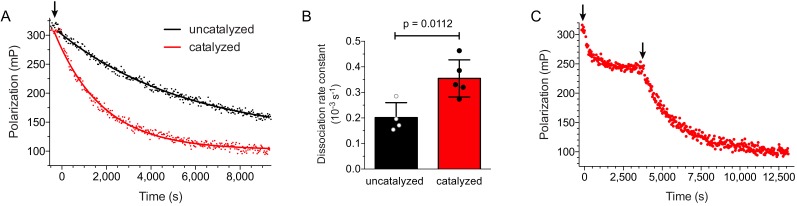
TAPBPRwt-catalyzed displacement of high-affinity peptide from H2-Db.(A) Peptide dissociation kinetics (representative traces) from H2-Db (300 nM) loaded with a fluorescently-labeled high-affinity peptide (ASNC*NMETM) was monitored in real time by fluorescence polarization. The arrow indicates the addition of a 1000-fold molar excess of unlabeled high-affinity peptide (ASNENMETM, 300 µM) without TAPBPRwt (black trace) or in combination with TAPBPRwt (1 µM, red trace). (B) Average rate constants of uncatalyzed (0.20 ± 0.06 × 10−3 s−1) and catalyzed dissociation (0.35 ± 0.07 × 10−3 s−1) of high-affinity peptide from H2-Db, using the same conditions as in (A). Data represent mean ± SD (uncatalyzed: n = 4; catalyzed: n = 5). The p value was determined using an unpaired t test. (C) Representative trace (n = 3) of fluorescent high-affinity peptide displacement from H2-Db (300 nM), monitored by fluorescence polarization after addition of TAPBPRwt (1 µM, first arrow) and after subsequent addition of a 1000-fold molar excess of unlabeled high-affinity peptide (300 µM, second arrow). Abbreviation: mP: milli-polarization units.